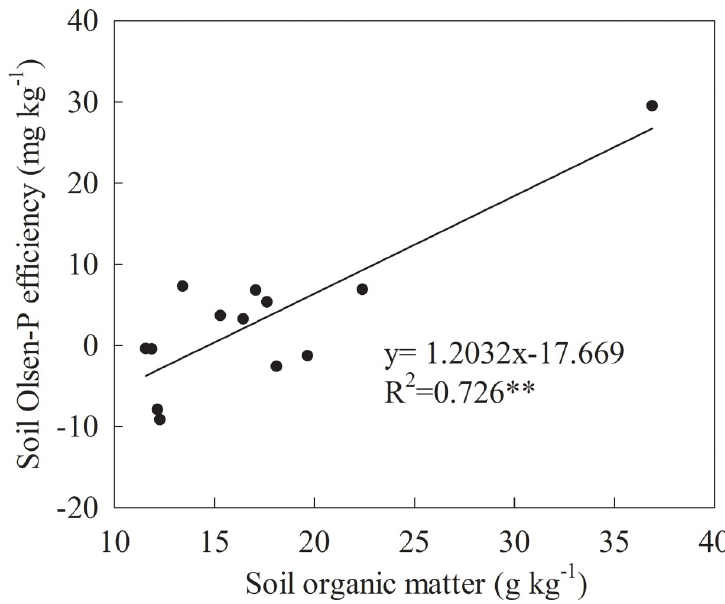
Fig 7. The relation between soil organic matter and soil Olsen-P efficiency of the three sites.